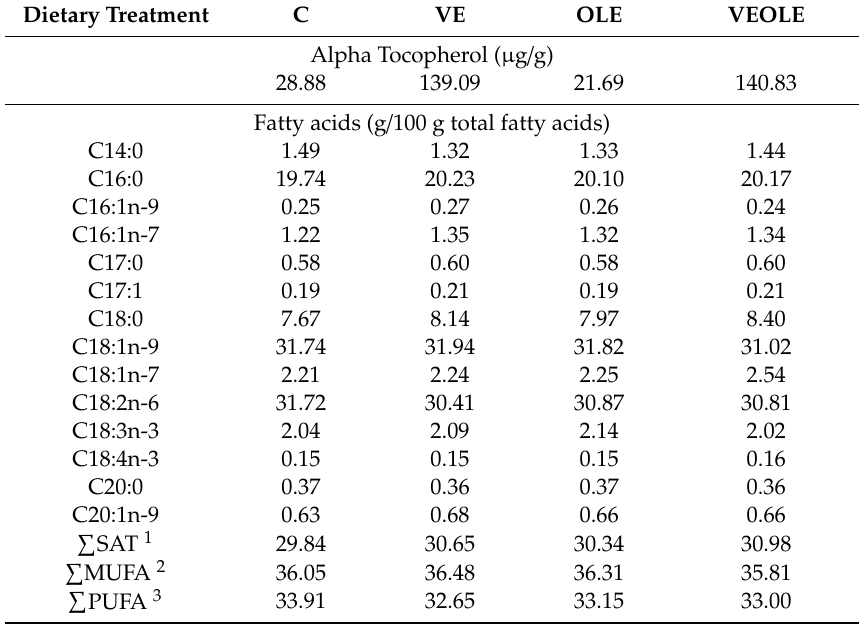
Table A1. Ingredients, major nutrients, and analyzed composition of the experimental diets. Dietary